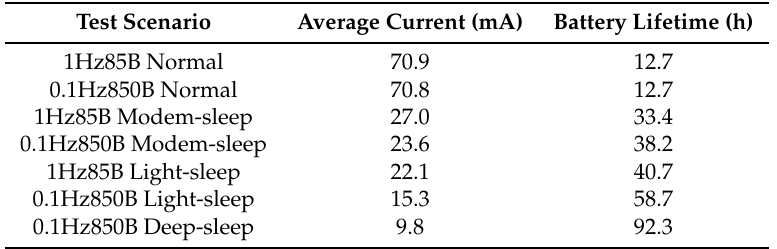
Table 2. Average current and expected battery lifetime for each test scenario.